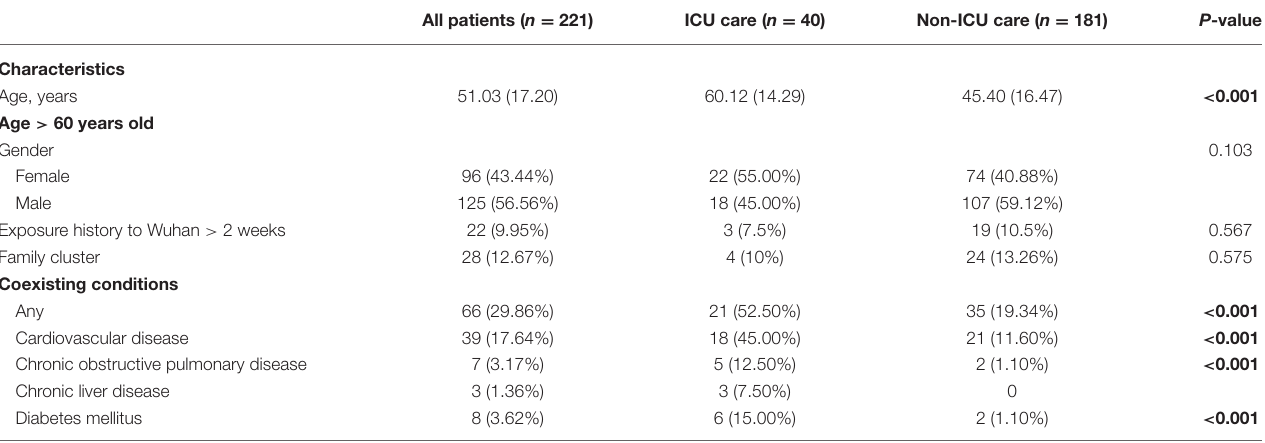
TABLE 1 | Demographics and baseline characteristics of patients with COVID-19 pneumonia. All patients ( n =